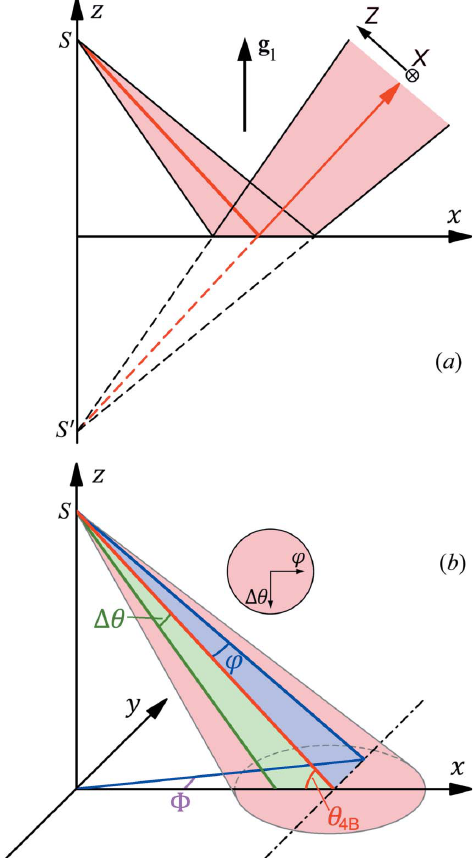
Figure 4 ( a ) Mirror reflection law of symmetric Bragg reflection. The virtual source S 0 is exactly the mirror image of the real point source S with respect to the crystal surface ( z = 0). ( b ) Relationship between the lateral divergence angle ’ and the azimuthal angle (cid:2) on the crystal surface ( z = 0). The inset indicates the cross section of the divergent beam viewed along the direction opposite to the beam